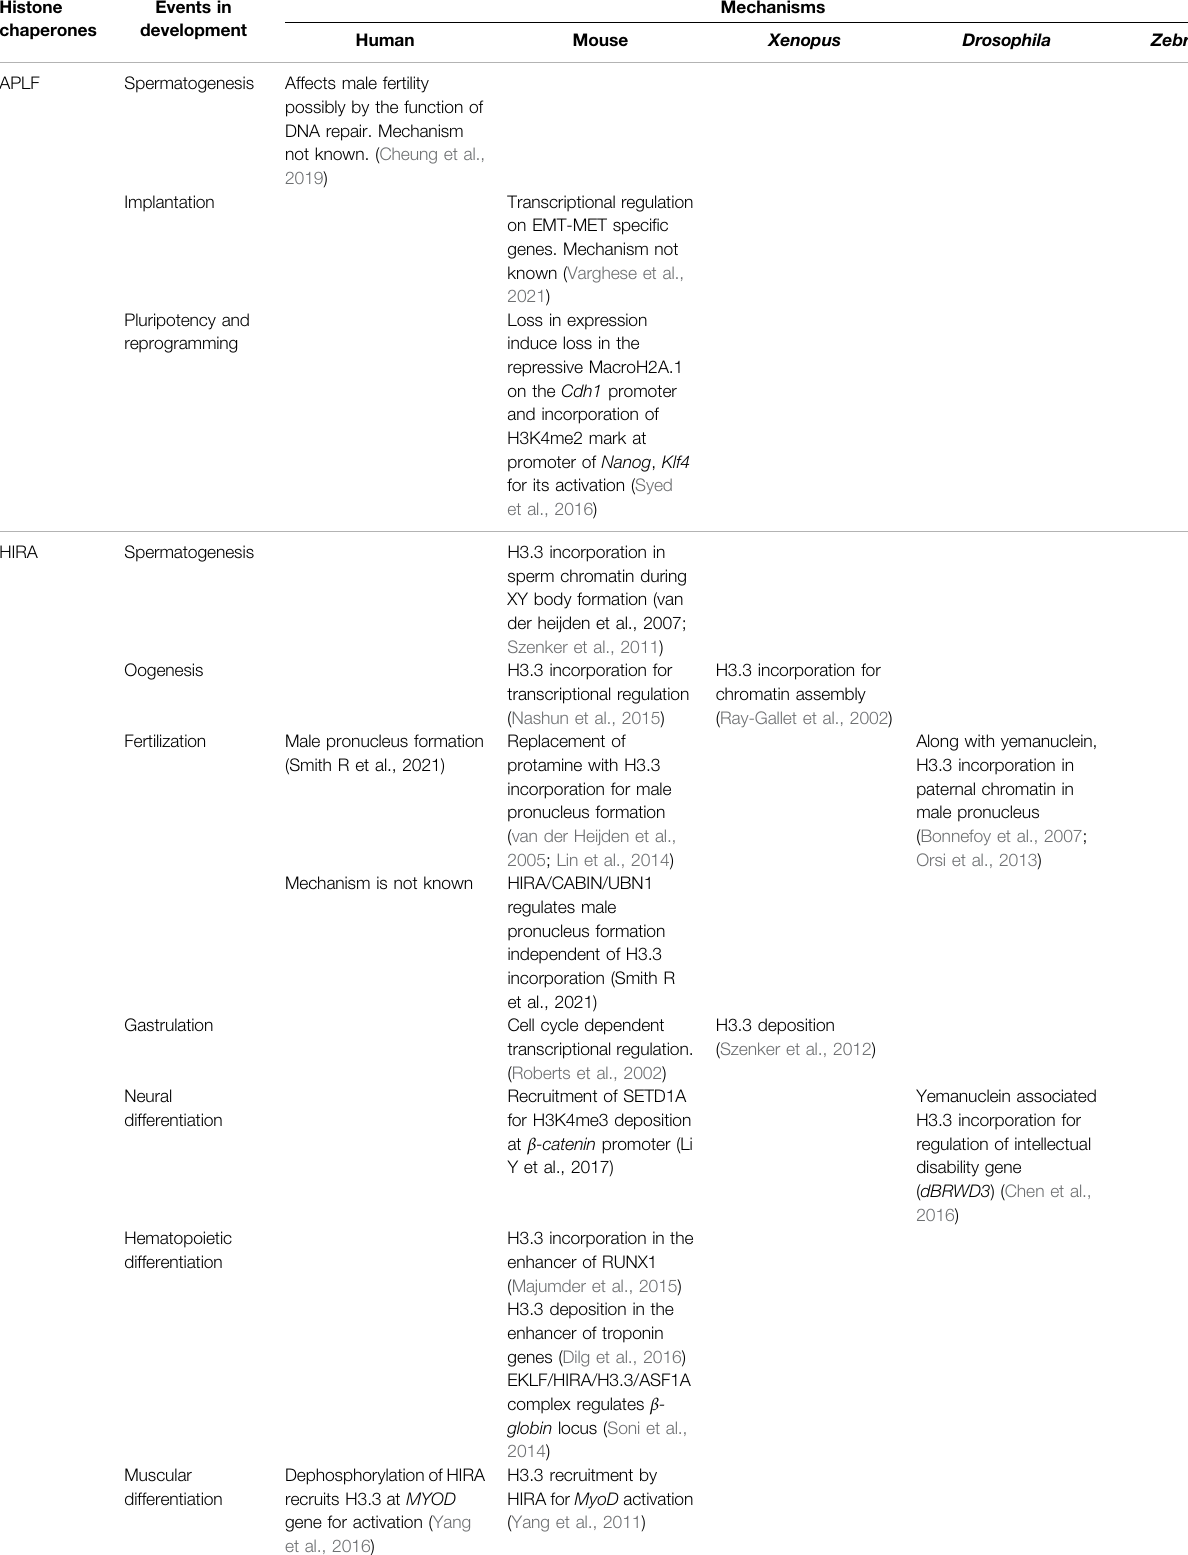
TABLE 2 | Mechanistic regulation mediated by histone chaperones during development in multiple species. Histone